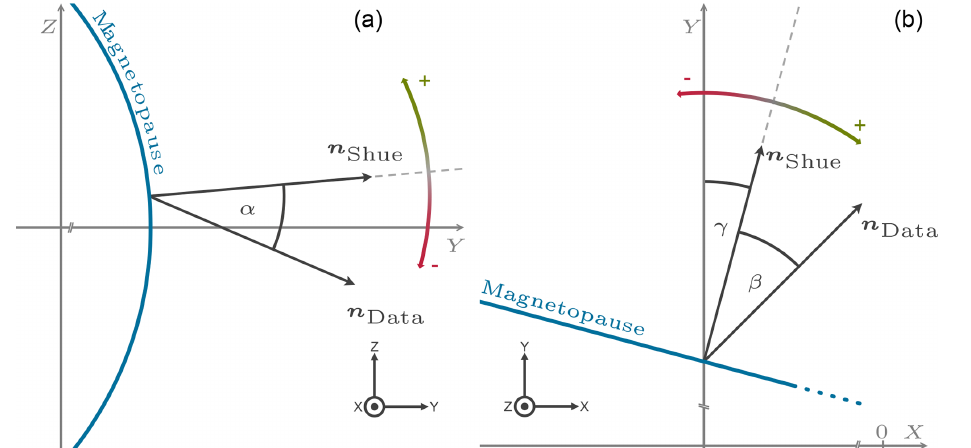
Figure 8. To compare the normal directions of the model and data, angles are measured as deviation from model direction. The angle α (front view, a ) corresponds to deviation in the rotational symmetry, whereas β (top view, b ) corresponds to the MP flaring or short-term perturbations. The expected opening angle γ of the model is shown in Figs. 9 and 10.